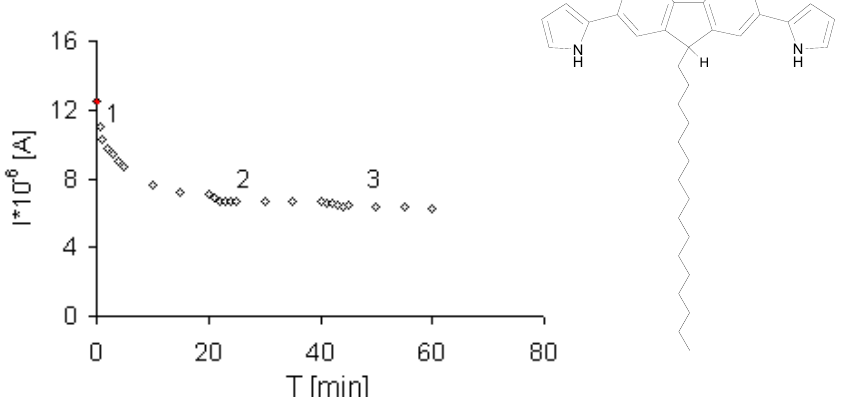
Figure 5. Response of one LB layer thick sensor 2 to increasing concentrations of NH during 60 minutes. In each step, the NH the initial signal as red point [30].